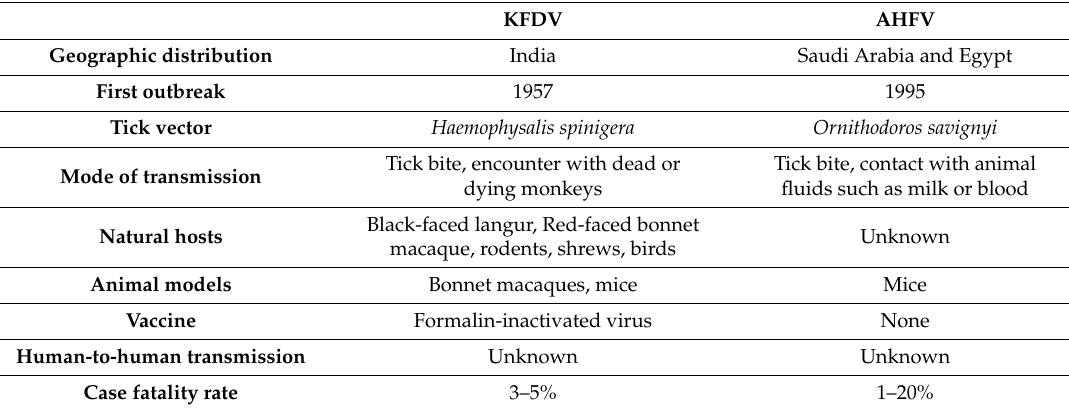
Table 1. Characteristics of Kyasanur Forest disease virus (KFDV) and Alkhurma hemorrhagic fever virus